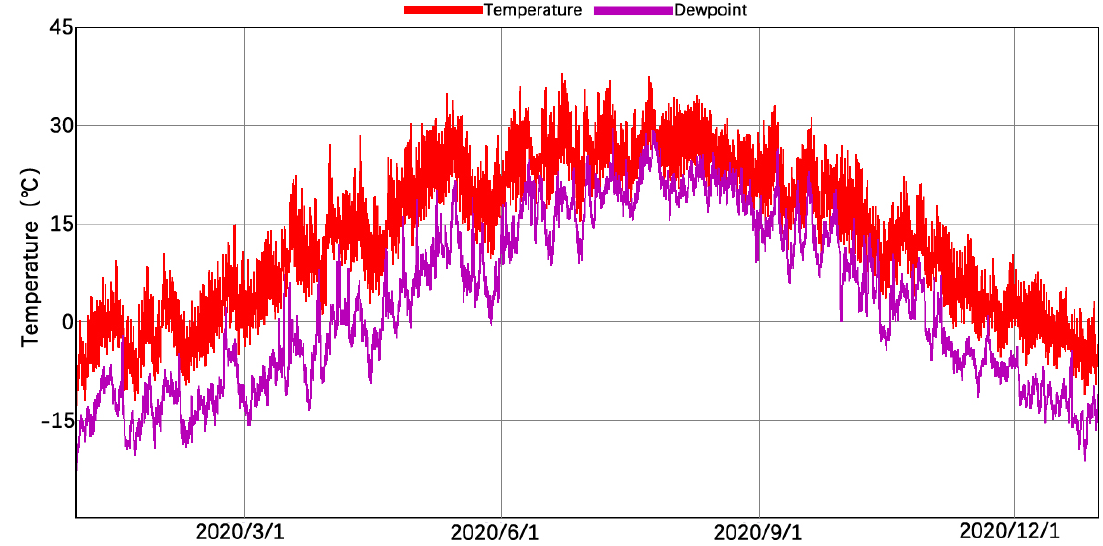
Figure 16. Dewpoint and temperature of monitoring point 1.